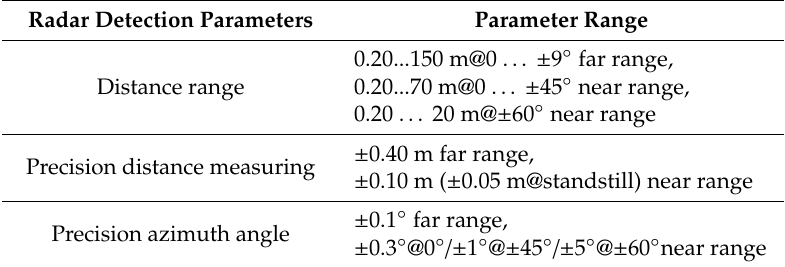
Table 1. Measurement range and precision of the millimeter-wave